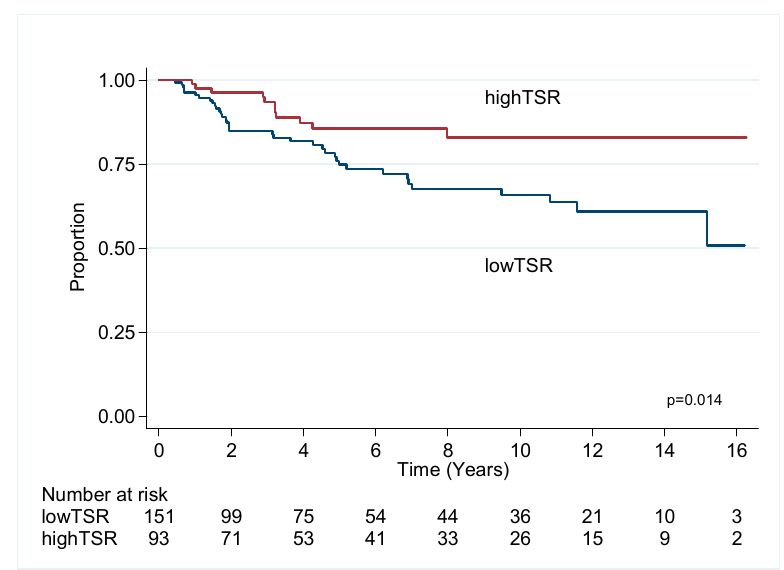
Figure 2. Kaplan–Meier survival estimates for breast cancer specific survival in TNBC.